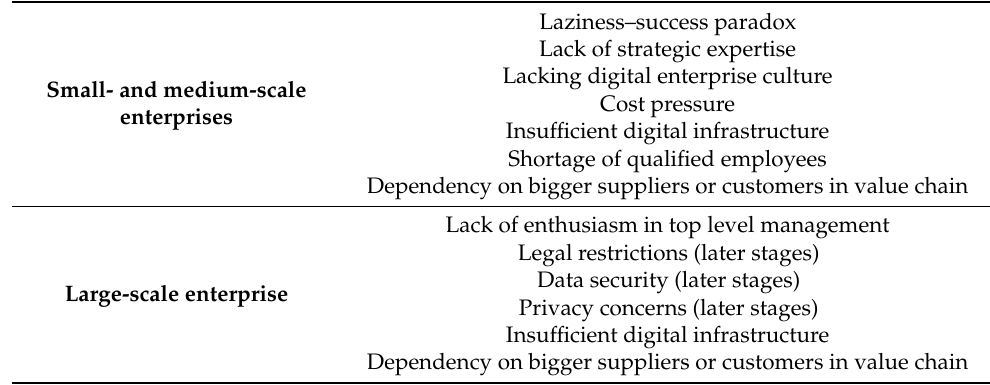
Table 1. Hindering factors of Industrie 4.0 in Germany per company type (Own Illustration).